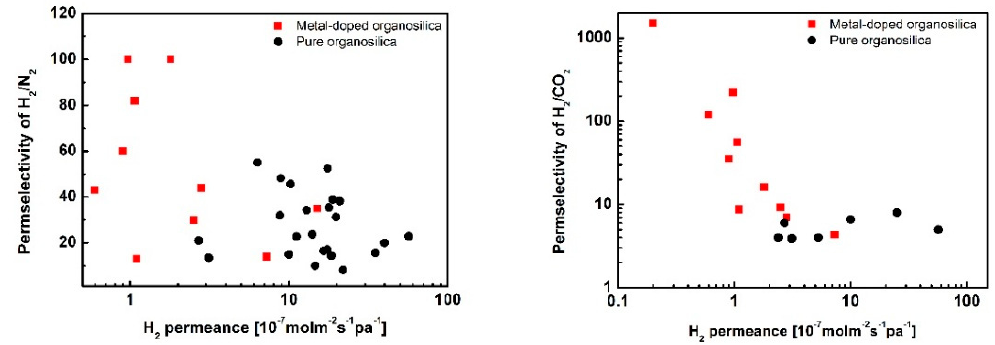
Figure8. H 2 separationperformanceofMetal-dopedorganosilicamembranesandcomparedwithorganosilica Figure 8. H 2 separation performance of Metal-doped organosilica membranes and compared with membranes at 200 ◦ C. Square data from Ref. [27,81–83,92,93], cycle data from Ref. organosilica membranes at 200 °C. Square data from Ref. [27,81–83,92,93] , cycle data from Ref. [16,27,35,94] .